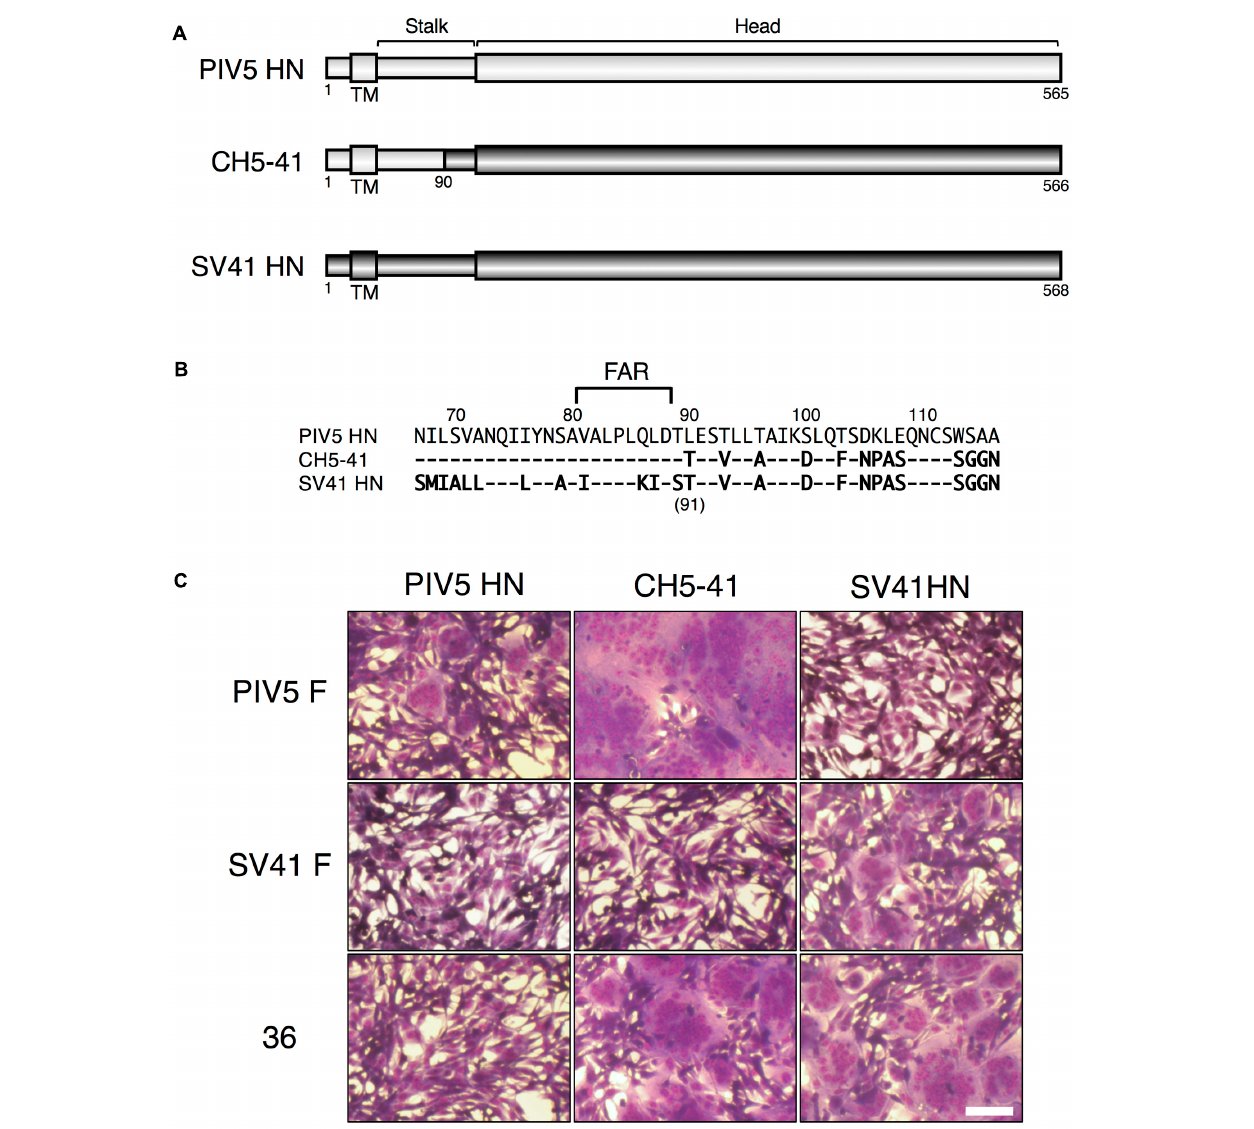
FIGURE 1 | The HN protein specificity of the SV41 F-like chimeric F protein no. 36 is not identical to that of the SV41 F protein. (A) Schematic diagrams of the PIV5 HN protein, SV41 HN protein, and the chimeric HN protein, CH5-41. Black cylinders represent regions derived from the PIV5 HN protein, while gray cylinders represent regions derived from the SV41 HN protein. (B) Amino acid sequence alignment of the stalk domains of the PIV5 HN protein, CH5-41, and the SV41 HN protein. Dashes in the CH5-41 and SV41 HN protein sequences indicate the amino acids identical to the PIV5 HN counterparts. (C) Syncytia induced by co-expression of HN and F proteins. Subconfluent BHK cells grown in six-well culture plates were transfected with a mixture of 1 µ g/well of the pcDL-SR α expression vector encoding each HN protein and 2 µ g/well of the pcDL-SR α expression vector encoding each F protein. After 12 h of incubation at 37 ◦ C, the cells were fixed with 4% paraformaldehyde in PBS, treated with methanol, and stained with Giemsa’s solution. Bar, 100 µ